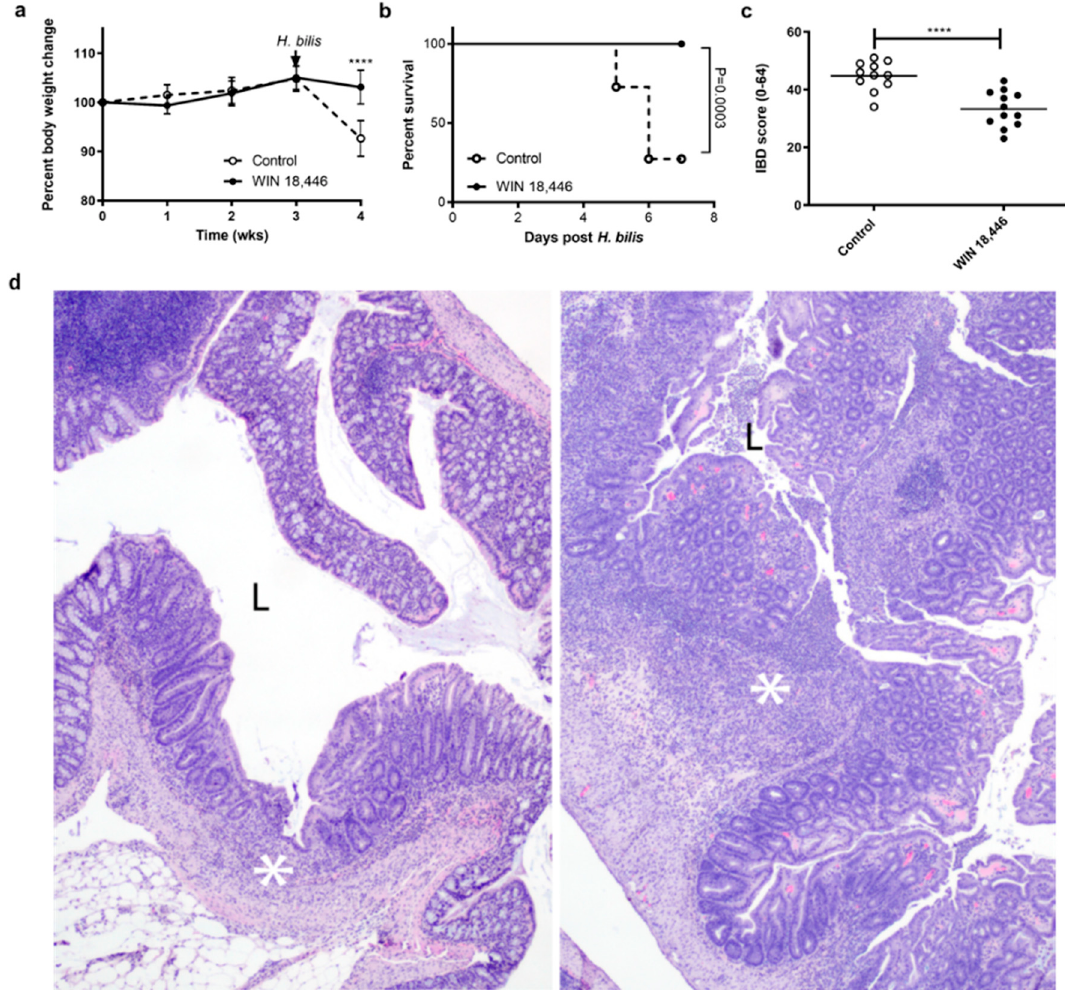
Figure 1. WIN 18,446 treatment protects Smad3 − / − mice from developing severe colitis. Male and female mice (n = 24; 12/group, age ‐ and sex ‐ matched between the groups) were weighed weekly following the diet initiation. H. bilis infection to trigger inflammatory bowel disease (IBD) occurred at 3 weeks post diet initiation (arrow). Mice were necropsied at days 5–7 post H. bilis infection. ( a ) Weight change is expressed as percent of baseline. Error bars are SD, **** p < 0.0001, Mann–Whitney. ( b ) Survival analysis during the 7 days post H. bilis infection was performed using Log ‐ rank test. ( c ) Colitis severity (IBD score) was significantly reduced in Smad3 − / − mice by treatment with WIN 18,446 as assessed by histological analysis. Horizontal line is the mean score, **** p < 0.0001, Student’s T test. ( d ) Representative hematoxylin & eosin (H&E) ‐ stained sections of proximal colon from mice with IBD scores near the mean for each group; left WIN ‐ treated (IBD score 29), right control (IBD score 45). In both colons, there is evidence of ulceration (asterisks). In the control, the ulceration is markedly increased in size and severity; there is active and severe ulceration with cellular exudates in the lumen (L). In contrast, the WIN-treated animal has a healing ulcer where re-epithelization has occurred and there are minimal cells within the lumen (L). Original magnification 100X.